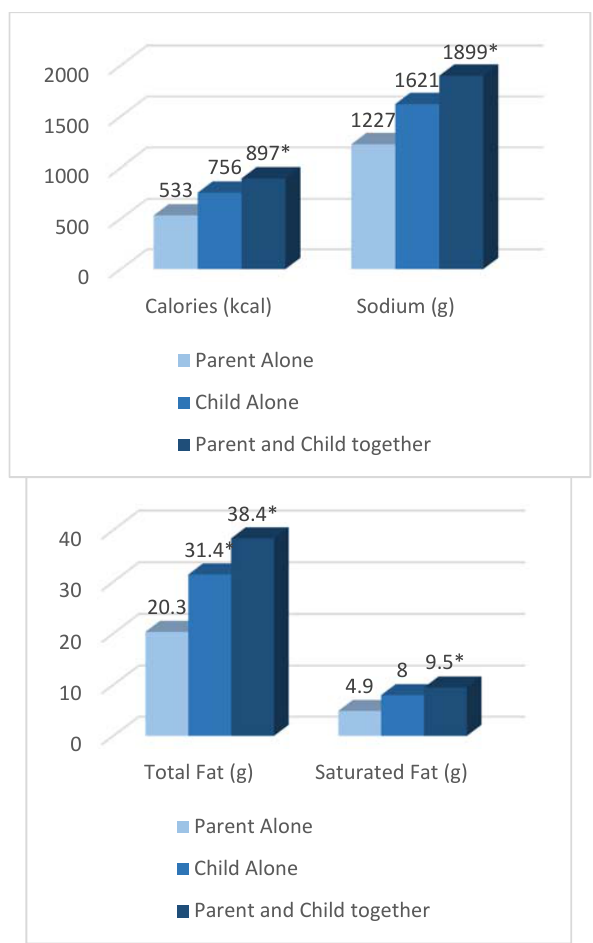
Figure 3. Consumption of nutrients from the overall meal by who made the ordering decision (parent alone, child alone, or child and parent together).* Significantly different ( p < 0.05) by who made the ordering decision (parent alone (reference group), child alone, or child and parent together) using mixed ‐ model analysis of variance with restaurant location as a random effect and adjusting for QSR chain, child age, child sex, child ethnicity, parent sex. Values were calculated using least squares mean regression.